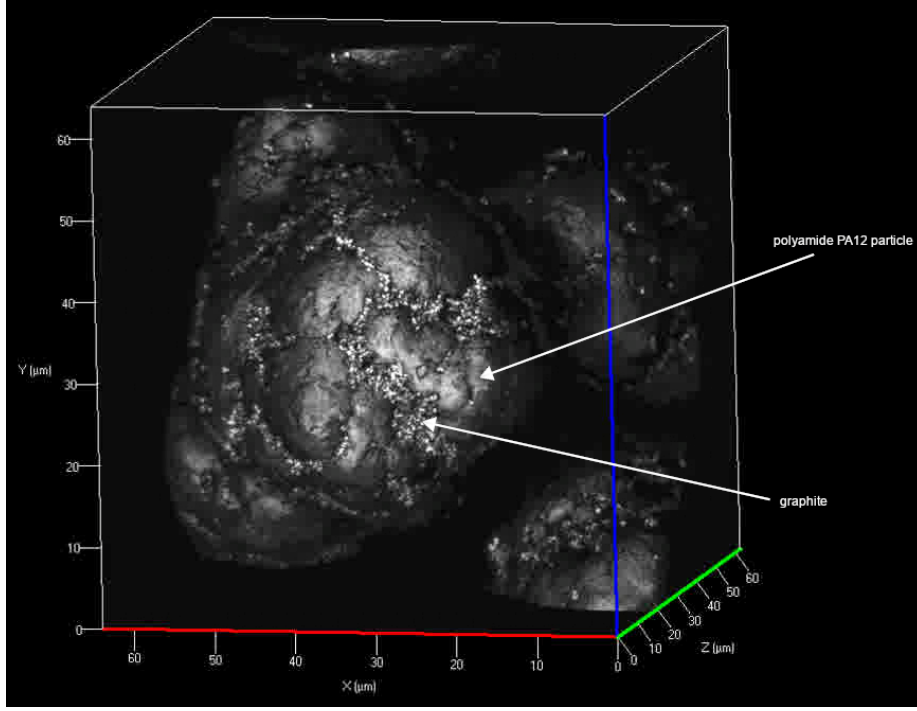
Figure 1. Particles of “Sinterit PA 12 smooth” for laser sintering (confocal laser scanning microscope).